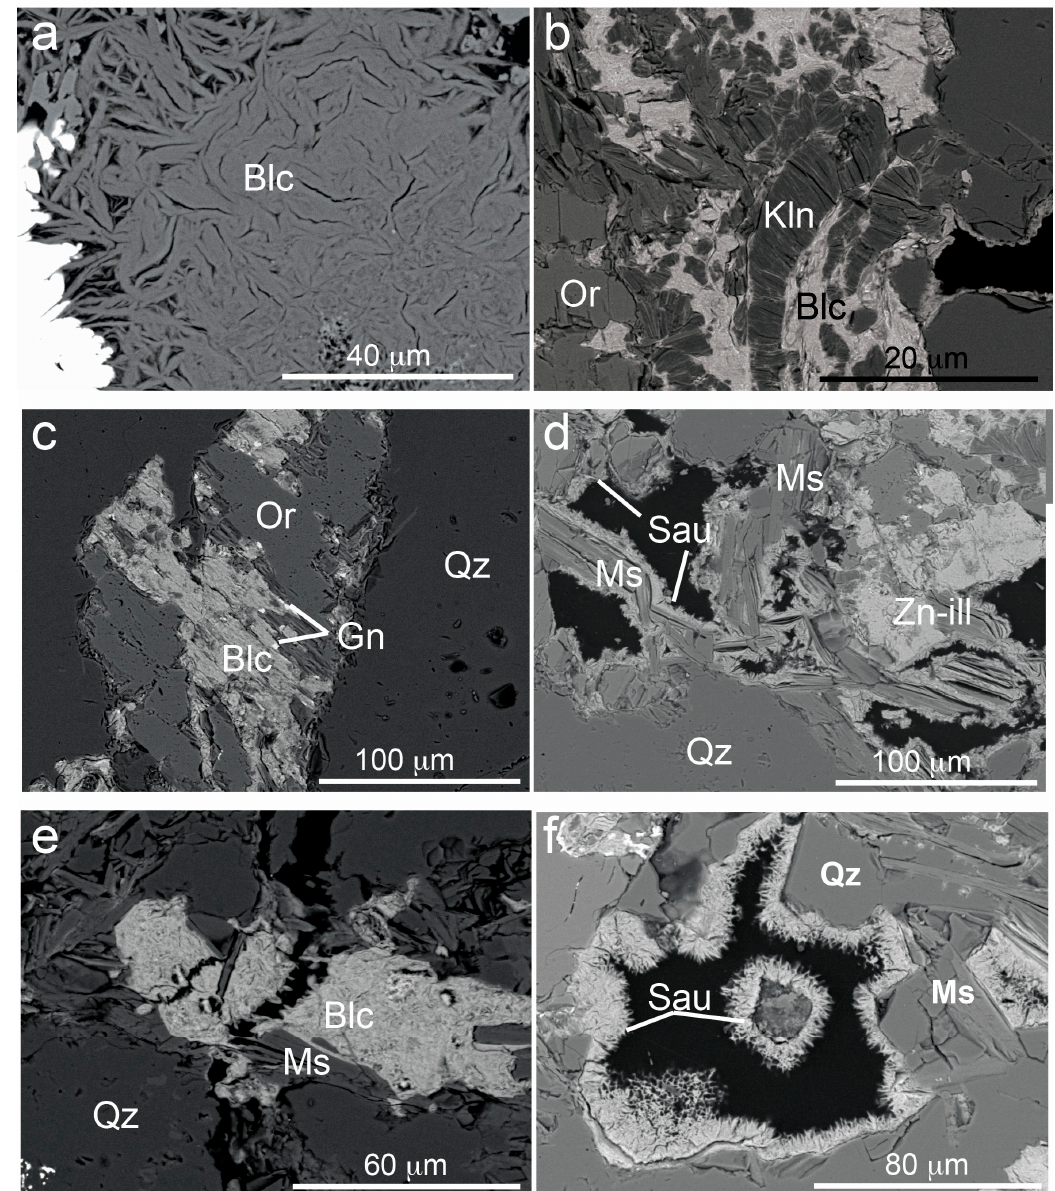
Figure 10. Backscatter electron SEM micrographs. Mineral chemistry was determined through EDS. ( a ) KDD 143-23. Baileychlore packages, randomly oriented, filling porosity; ( b ) KDD 143-22. Baileychlore associated with kaolinite replacing orthoclase; ( c ) KDD 143-26. Orthoclase crystal from the host quartzwacke partially replaced by baileychlore; fine galena is associated with the Zn-chlorite; ( d ) KDD 143-26. Sauconite and Zn-bearing illite growing in dissolution cavities, above mica packages; ( e ) KDD 143-22. Patches of baileychlore growing in between mica packages and quartz grains; ( f ) KDD 143-26. Dissolution cavity bordered by freely growing sauconite. Blc = baileychlore; Gn = galena; Kln = kaolinite; Ms = muscovite; Or = ortoclase; Qz = quartz; Sau = sauconite; Sm = smithsonite; Zn-ill = Zn-bearing illite.